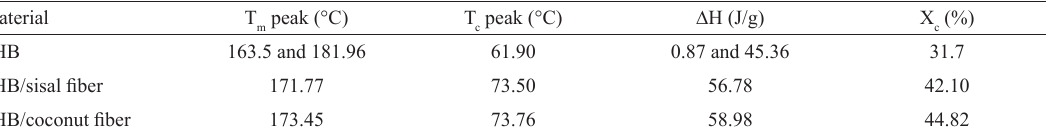
Table 1: Thermal properties of PHB and composites after molding. Maximum melting temperature (T (∆H); crystallinity (X ). c